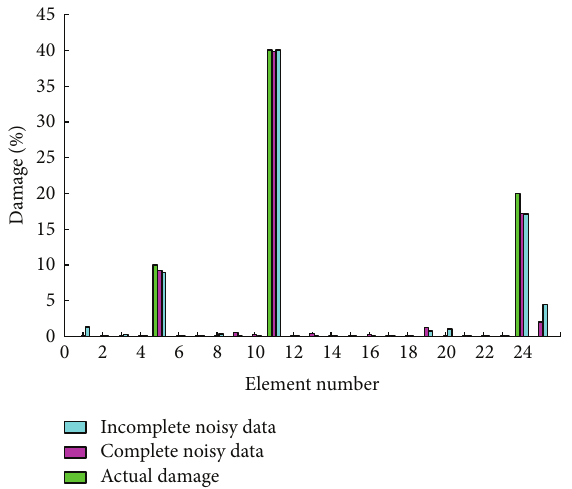
Figure 8: Damage distribution of Bowstring truss using the com- plete and incomplete noisy data in Scenario 1.